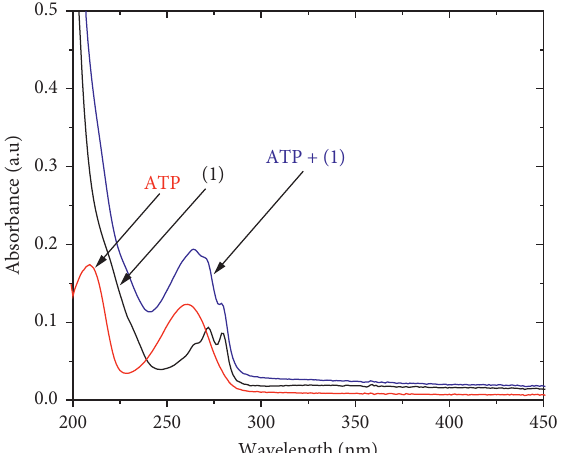
Figure 2: UV-Vis absorption spectra of 1 (24mg/L) and ATP (10 − 4 M) in Tris-HCl buffer solution (pH 7.4).